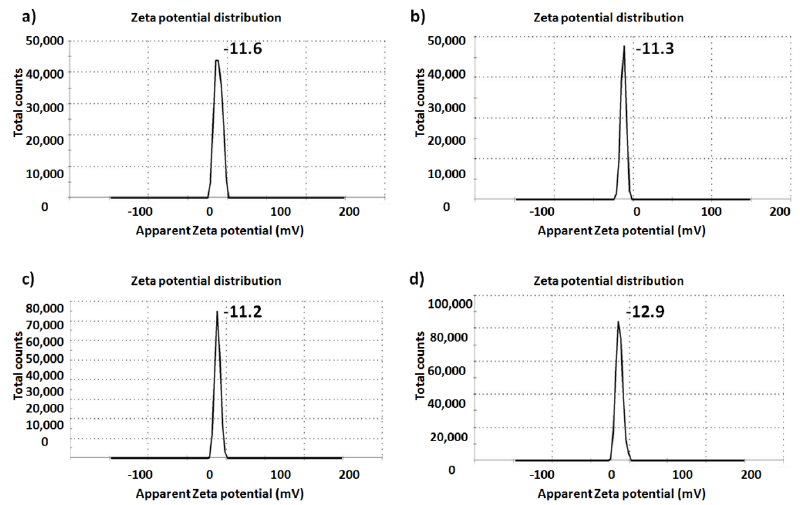
Figure 7. Particlesurface charges of ( a ) Base, ( b ) BGT5, ( c ) BGT7.5 and ( d ) BGT10 determined by Zetasizer.